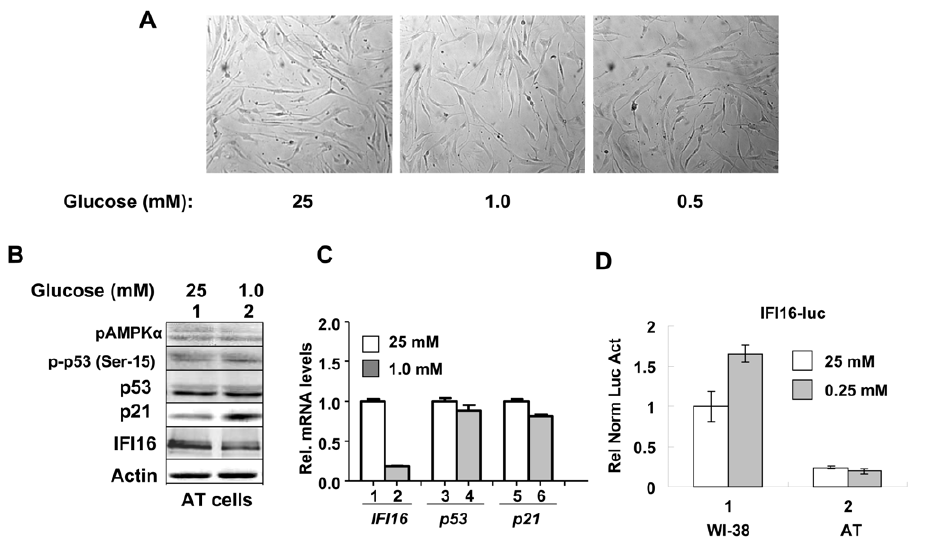
Figure 4. Glucose restriction-induced activation of the AMPK/p53 pathway and increase in the IFI16 protein levels are ATM- dependent. ( A ) Sub-confluent cultures of young AT HDFs were incubated with the indicated concentrations (mM) of glucose in the medium supplemented with 10% fetal bovine serum for 18 h. At the end of the incubations, cells were photographed using a phase contrast microscope at a lower magnification. ( B ) Sub-confluent cultures of young AT HDFs were incubated with the indicated concentrations (mM) of glucose in the medium supplemented with 10% fetal bovine serum for 18 h. At the end of the incubations, cells were lysed and equal amounts of proteins were analyzed by immunoblotting using antibodies specific to the indicated proteins. ( C ) Total RNA isolated from AT HDFs incubated with the indicated concentration of glucose for 18 h was subjected cDNA synthesis, followed by quantitative real-time PCR using the TaqMan assay for the IFI16 , p53 , and p21 genes. ( D ) Sub-confluent cultures of young WI-38 or AT HDFs were transfected with the IFI16-luc reporter plasmid (1.8 m g) along with a second reporter pRL- TK (0.2 m g) plasmid as an internal control. After transfections, cells were incubated with the indicated concentrations of glucose. 40–44 h after transfections, firefly luciferase and Renilla luciferase activities were assayed using dual-luciferase reporter assay kit. Relative luciferase activity was expressed as the ratio of the firefly luciferase and Renilla luciferase activity. The numbers indicate fold change in the activity of the firefly luciferase. The experiments were repeated two times with essentially similar